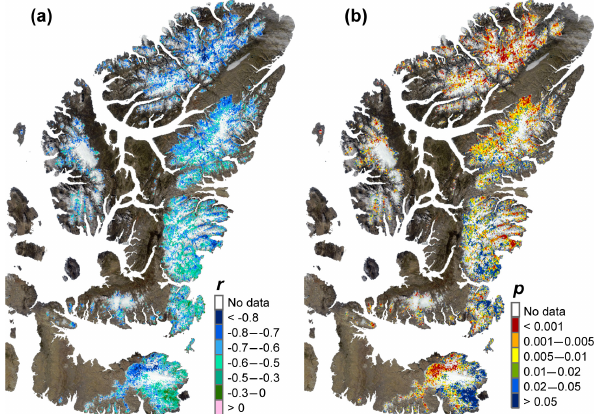
Figure 10. (a) Pearson correlation coefficient ( r ) and (b) p value for linear regression of the 16-year BSA and LST record for the QEI ice caps. Background image: MODIS, 4 July 2011. Brown indicates non-glaciated land